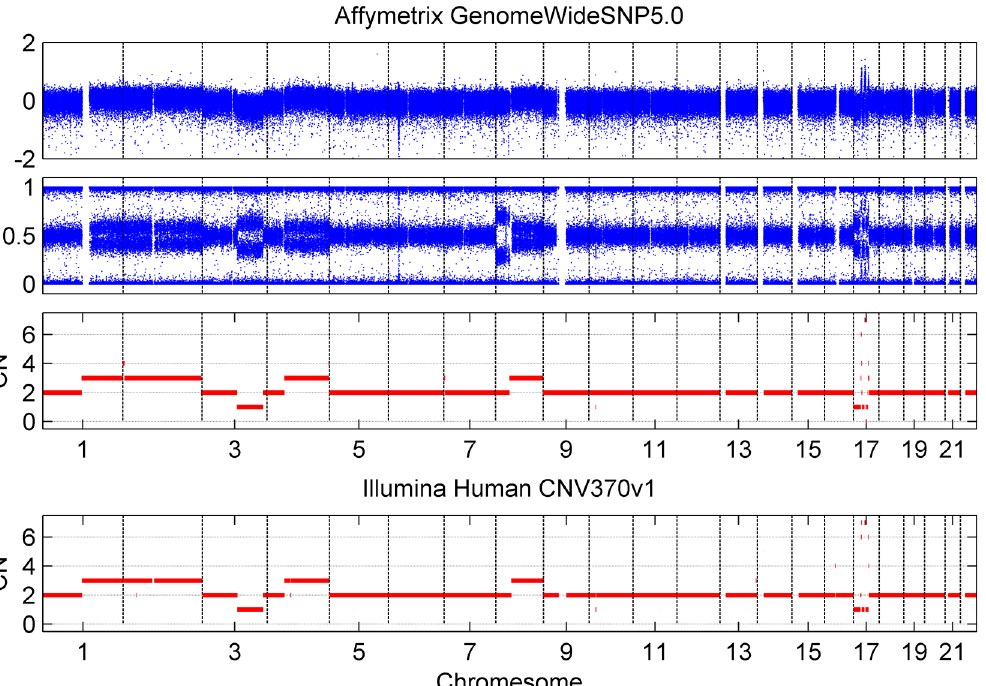
Fig 6. Comparison of results from TAFFYS and GPHMM. Comparison of genome-wide copy number profiles obtained from TAFFYS using Affymetrix GenomeWide5.0 SNP array and GPHMM copy number profile from Illumina HumanCNV370v1 SNP array analysis.